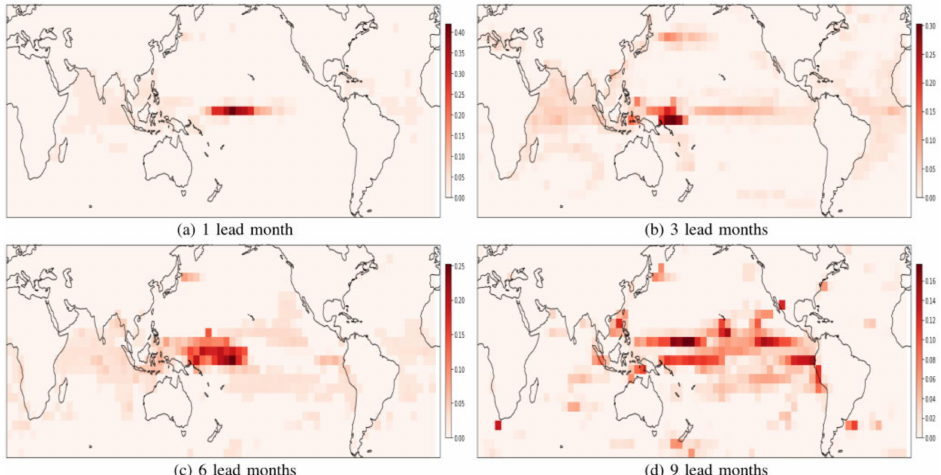
Figure 10. Heatmap of the effect of GNN predicting ENSO [70]. ( a – d ) respectively represent the heat map of GNN’s prediction of ENSO on a time scale of 1, 3, 6 and 9 months in advance.